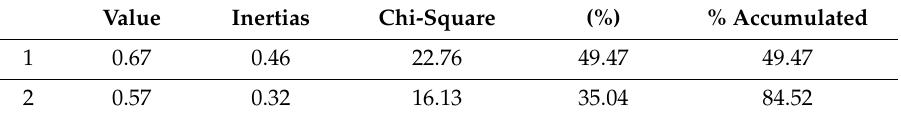
Table 2. Contribution to the Chi square of education and source of